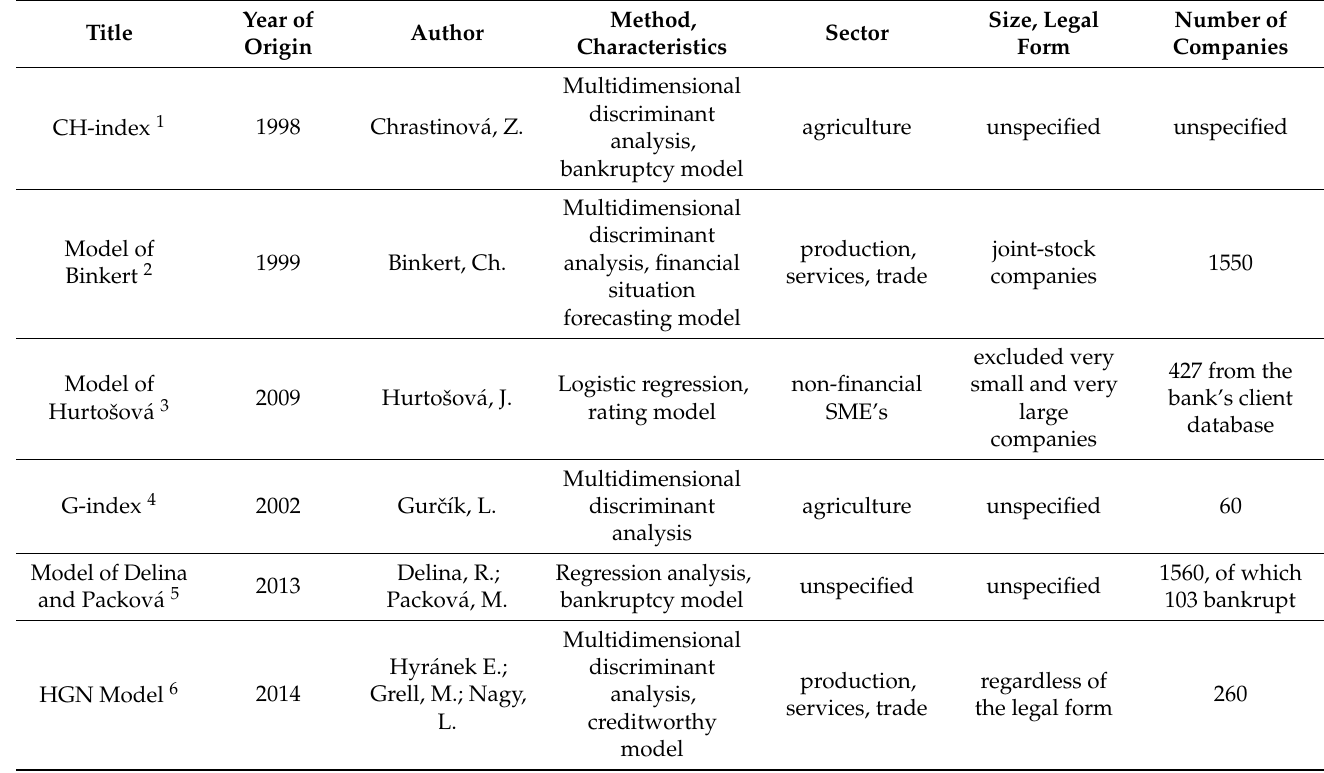
Table 1. List of local default prediction